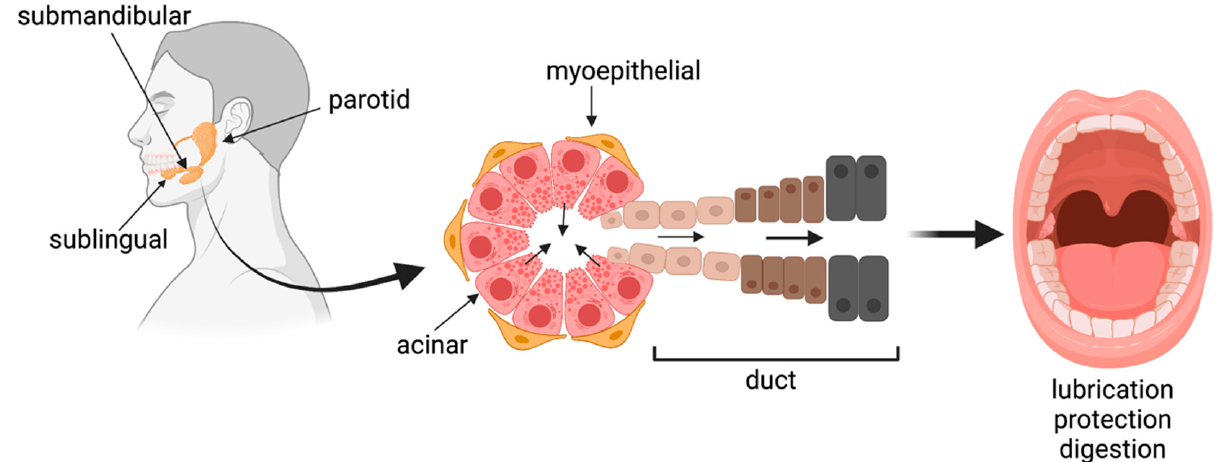
Figure 1. Schematic of the three major types of salivary glands, general gland structure, and major functions of saliva. Created with BioRender.com.